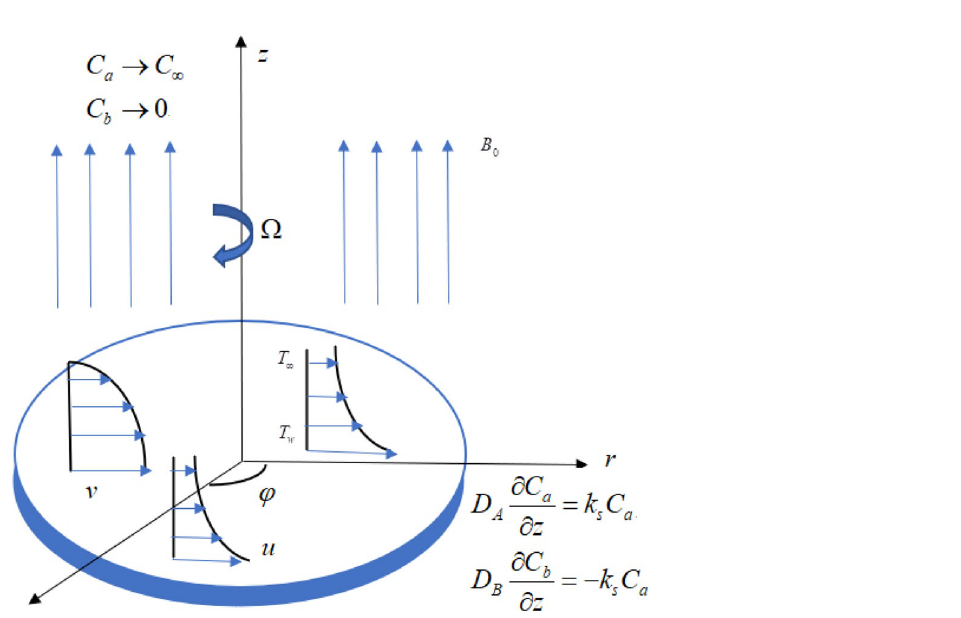
Figure 1. Geometrical sketch of the model